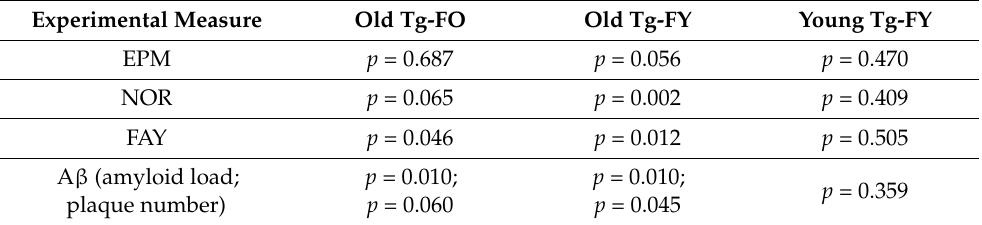
Table 1. Summary of difference in significance across experimental groups for behavioral studies